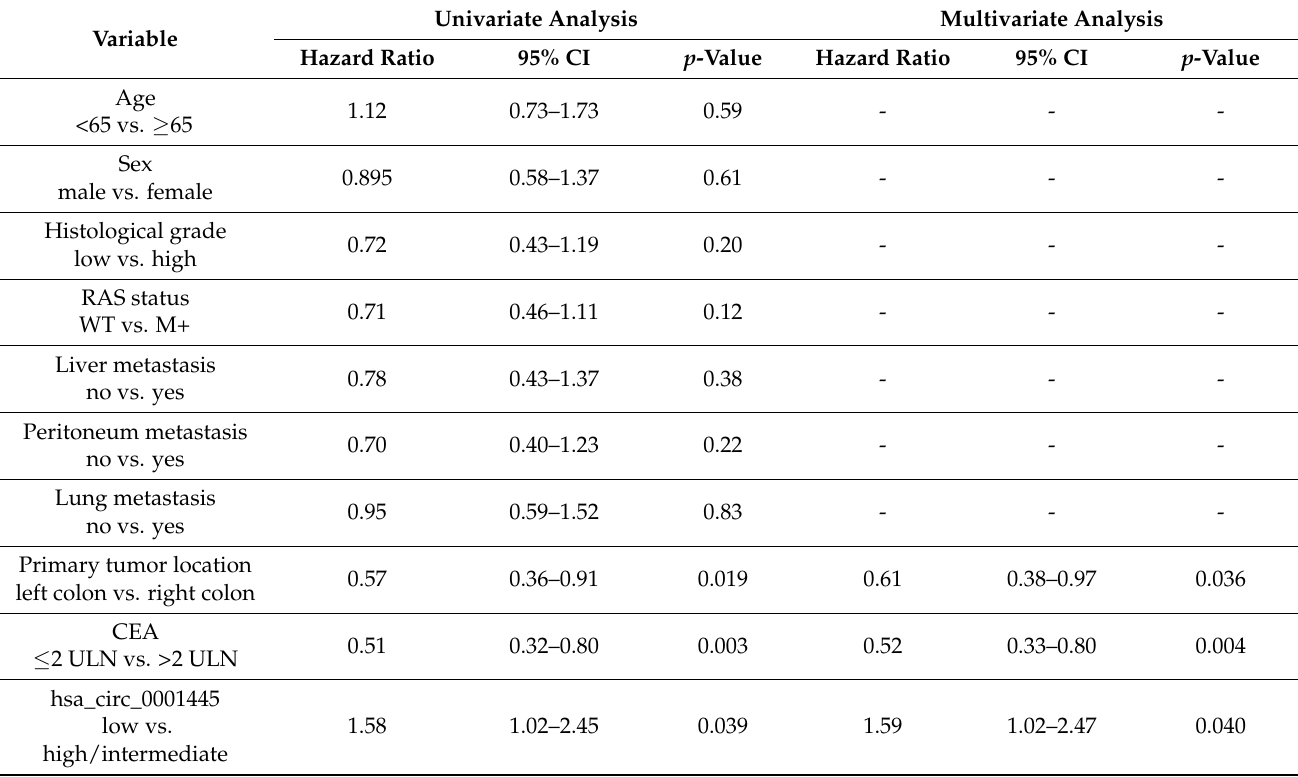
Table 3. Results of Cox regression analysis for predicting overall survival.